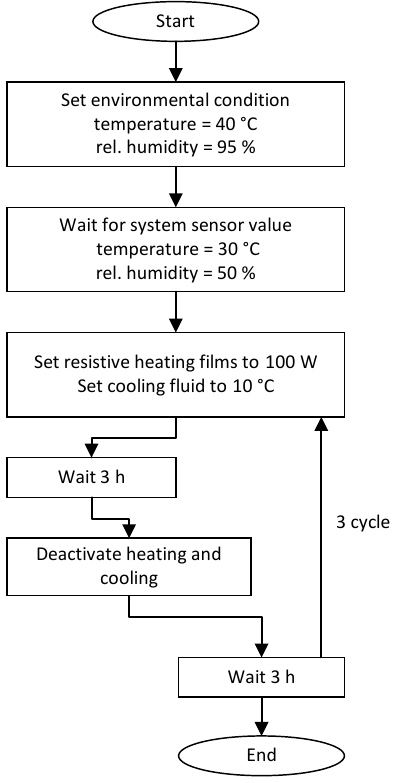
Figure 5. Test Profile 1 (for examination of the condensation during the normal operation of battery in hot and humid conditions).